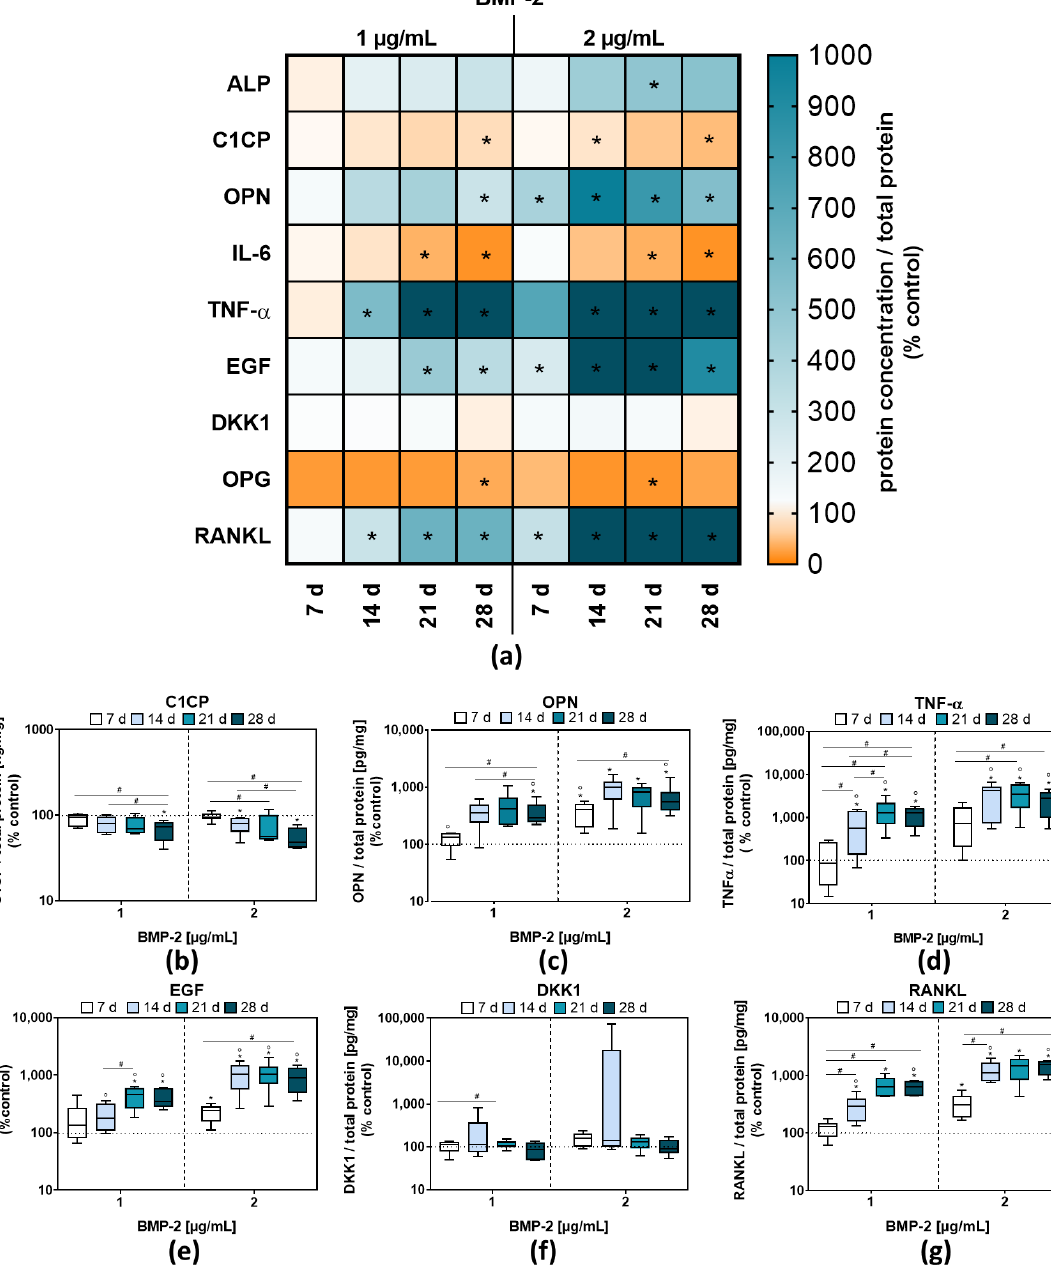
Figure 3. Protein concentrations in the supernatants of BMP-2 stimulated pre-osteoblasts after 7, 14, 21, or 28 days. ( a ) Data of secreted proteins depicted as heatmap. ( b – g ) Results of selected proteins secreted by human pre-osteoblasts. All data are depicted in relation to the total protein amount and relative to the control values. Results are shown as medians in the heatmap, * p < 0.05 compared to the control and # p < 0.05 compared to different time points and ° p < 0.05 compared to different concentrations using two-way ANOVA with Bonferroni’s multiple comparisons test ( n = 6). Osteopontin ( SPP1 ) mRNA transcripts were significantly increased after BMP-2 treat- ment compared to the unstimulated control (1 µ g/mL: p = 0.0446 (14 d), p = 0.0002 (28 d); 2 µ g/mL: p = 0.0399 (14 d), p = 0.0004 (28 d) (Figure 2a). The quantification of OPN,